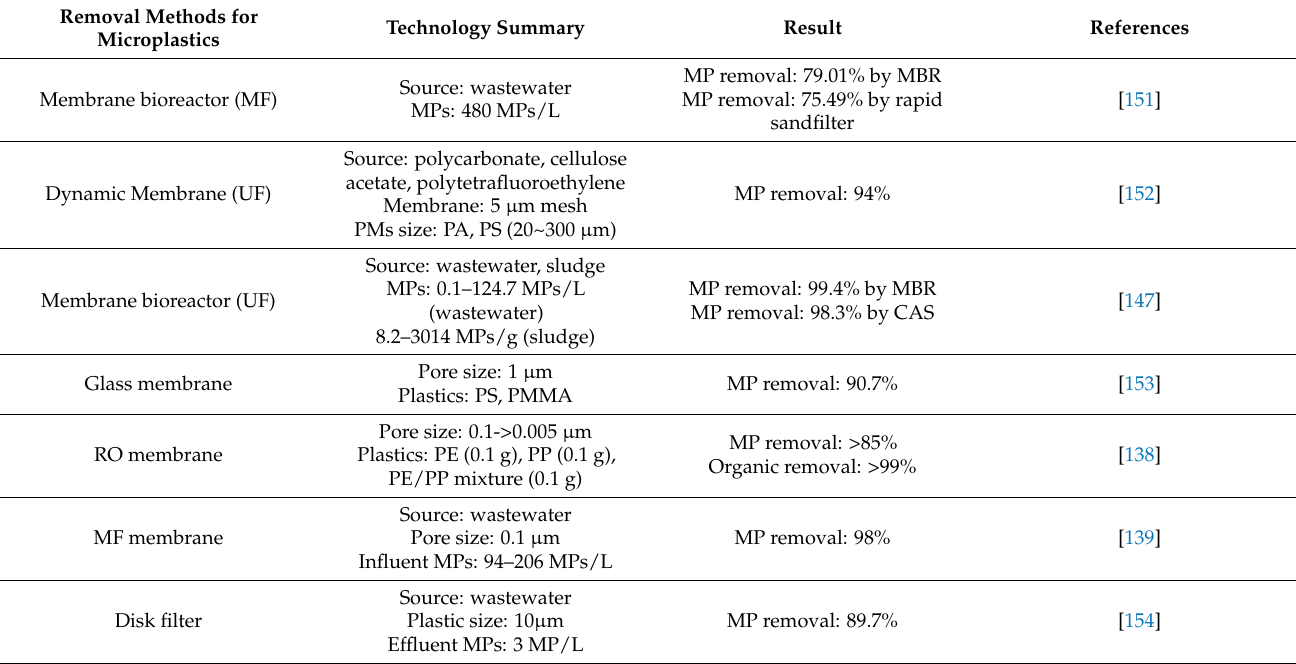
Table 9. Physical removal technology for